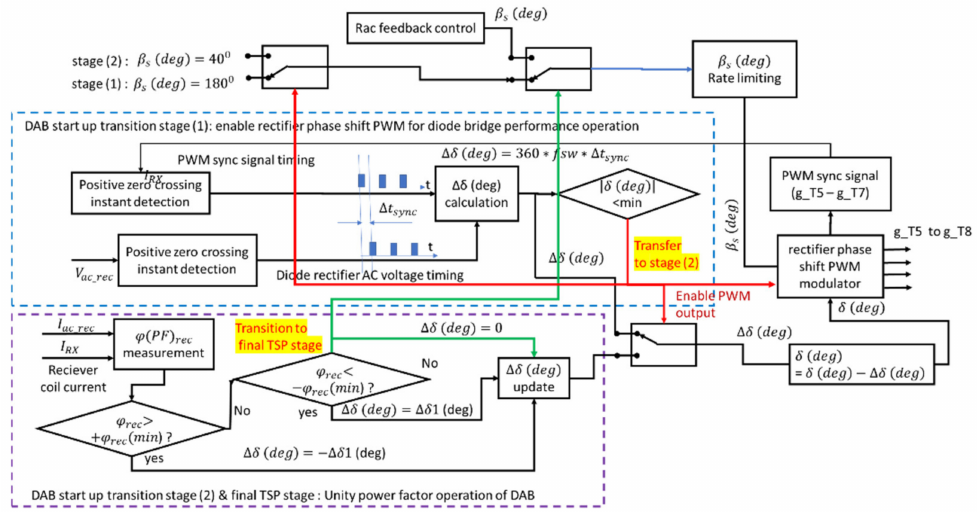
Figure 28. Function block diagram for DAB smooth startup transition from stage (1) to stage (2) and to the final TPS